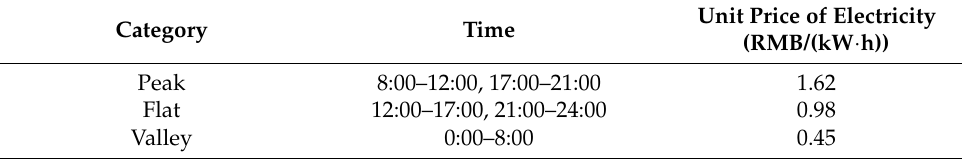
Table A3. Electricity tariff.